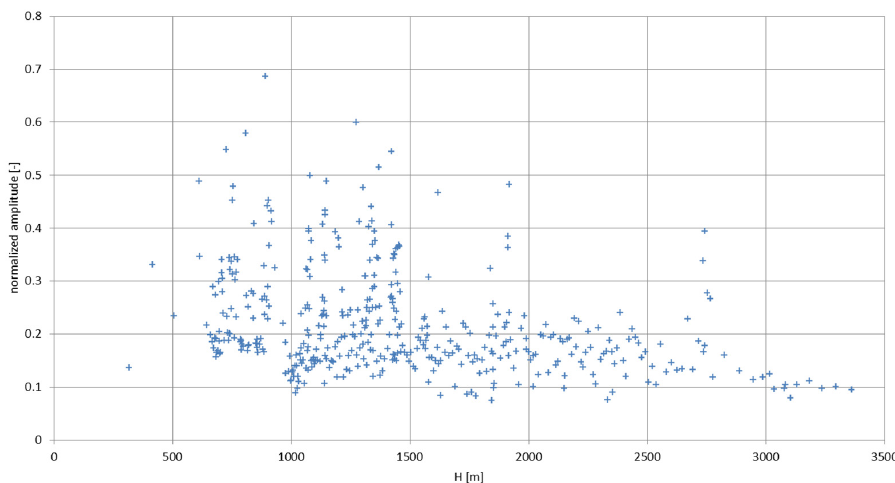
Figure 23. The recorded corona peaks extracted from the audio file. The higher concentration of corona discharges is directly linked to the increase of the electric field intensity around the balloon-borne antenna above a certain threshold value; the electric field strength, in order to excite the discharges, has to elevate itself rapidly in time—this property is manifested by the previously described dynamic model of electrification. The low altitude of the storm cloud during the experimental flight does not correspond to the lower cloud borderlines from the exemplary cases of the Ns clouds from Sankt Petersburg, Kyiv, and Tashkent due to local/climatic differences. As a best altitude match, Figure 24 presents the total electric field strength influenced by the antenna in the positively polarized Sc cloud (as in Figure 5b), in comparison with the corona discharges plotted in the form of a second-order moving-average function (splined values calculated as arithmetic average over two adjacent values). The most intense experimental corona region clearly corresponds to the zone where the highest calculated values of the total electric field strength inside the cloud are expected to appear, according to the calculations from the ‘dynamic’ model; the existence of the latter corona peaks can be attributed to, as previously mentioned, encountered cloud/charge irregularities at higher